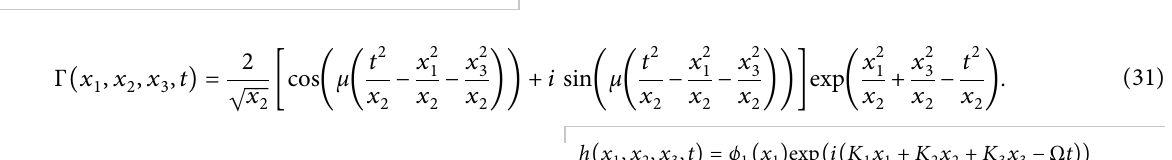
� − 0 . 09 and μ � 1 at t � 0 . 1. The 2 � − 0 . 09 and μ � 1 at t � 0 . 2